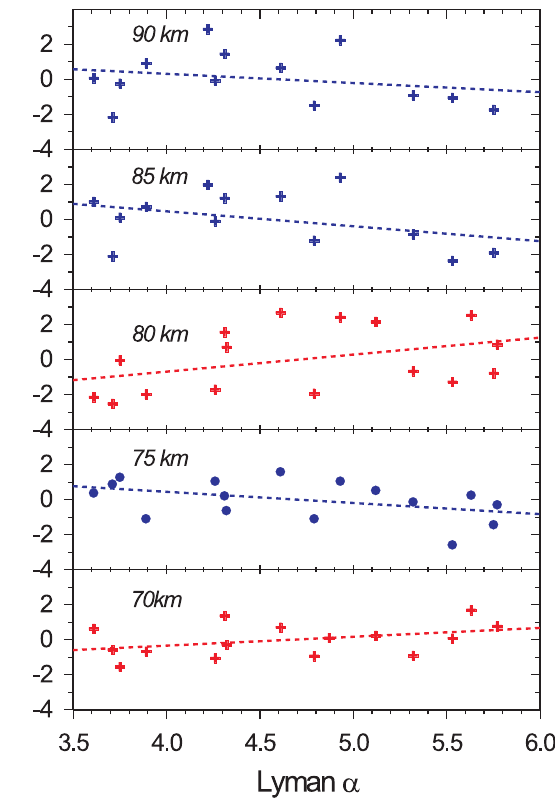
Fig. 11. Dependence of detrended values of the amplitude of the semidiurnal tide at Juliusruh on solar activity for yearly mean con- ditions at different heights. Positive relations are red, negative rela- tions blue. Significance levels are characterized by dashed lines and dots ( χ ≥ 90%), nonsignificant levels by dashed lines and crosses ( χ< 90%).